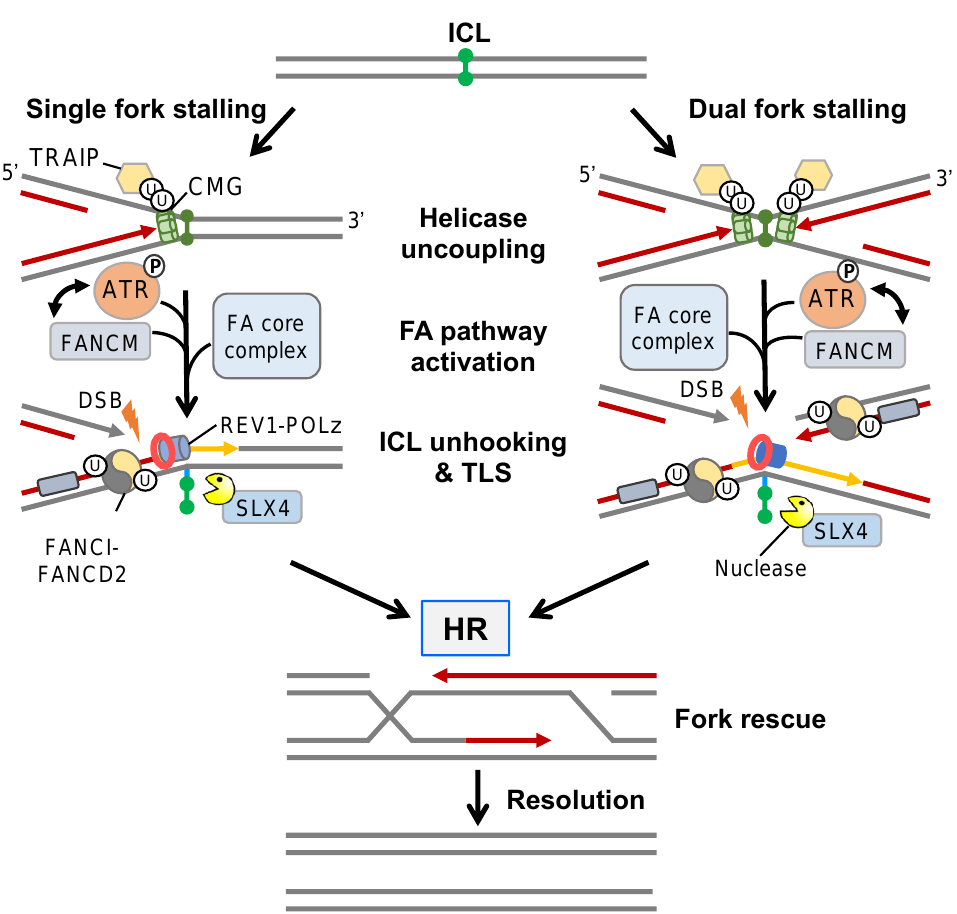
Figure 4. ICL repair by the FA pathway. The repair of an ICL in S-phase is initiated by a single fork stalling event or convergence of two stalled forks surrounding an ICL locus. After TRAIP-mediated disassembly of the CMG-replisome, the FANCM complex recognises the DNA crosslink and recruits members of the FA core complex and ATR, the latter facilitating a positive feedback loop with FANCM. The FA core complex monoubiquitylates dsDNA-bound FANCI-FANCD2 serving as the hub for the recruitment of structure-specific nucleases that, in cooperation with SLX4, incise the ICL site on both sides (5′ and 3′) of one parental strand generating a DSB in the opposite daughter chromatid. TLS polymerases (e.g., REV1 and POLζ) bypass the unhooked ICL restoring strand integrity of the first chromatid. The remnant ICL is subsequently removed by NER or BER, while the restored parental strand is used as a template for HR-mediated DSB repair.